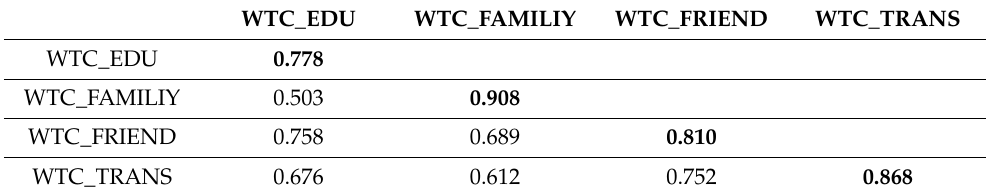
Table 2. Discriminant validity using the Fornell-Larcker criterion.